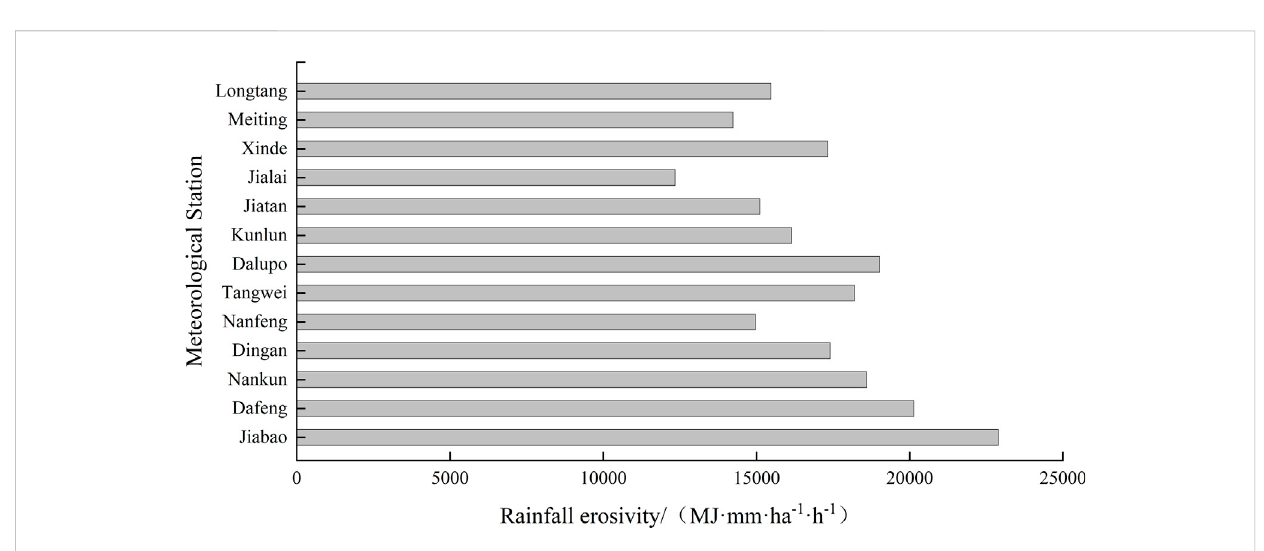
Average rainfall erosivity of meteorological stations in the Nandu River